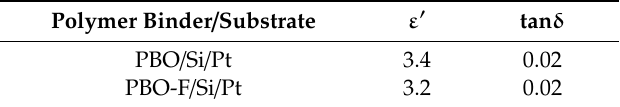
Table 1. The dielectric parameters of the film coatings based on PBO and PBO-F, measured at 200 kHz at room temperature.